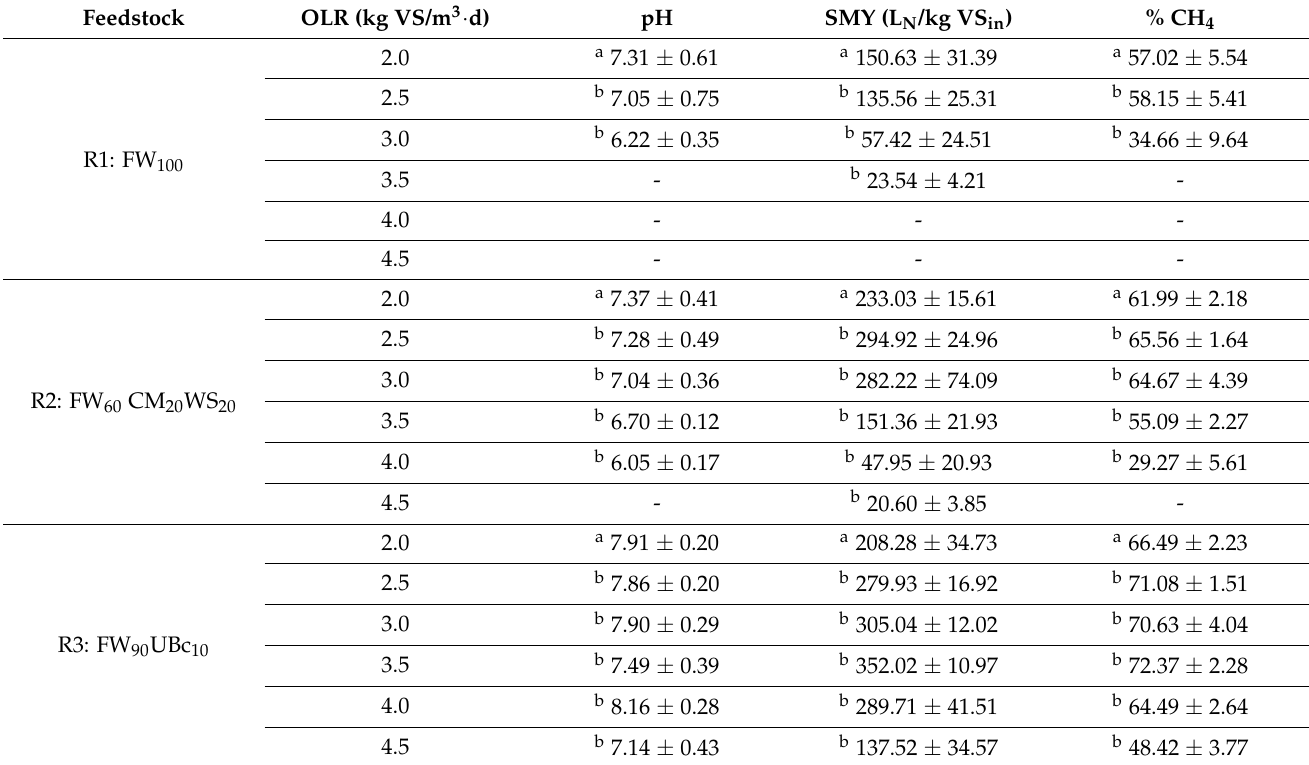
Table 5. In-situ biogas up vs. pH fluctuations (mean ± standard deviation